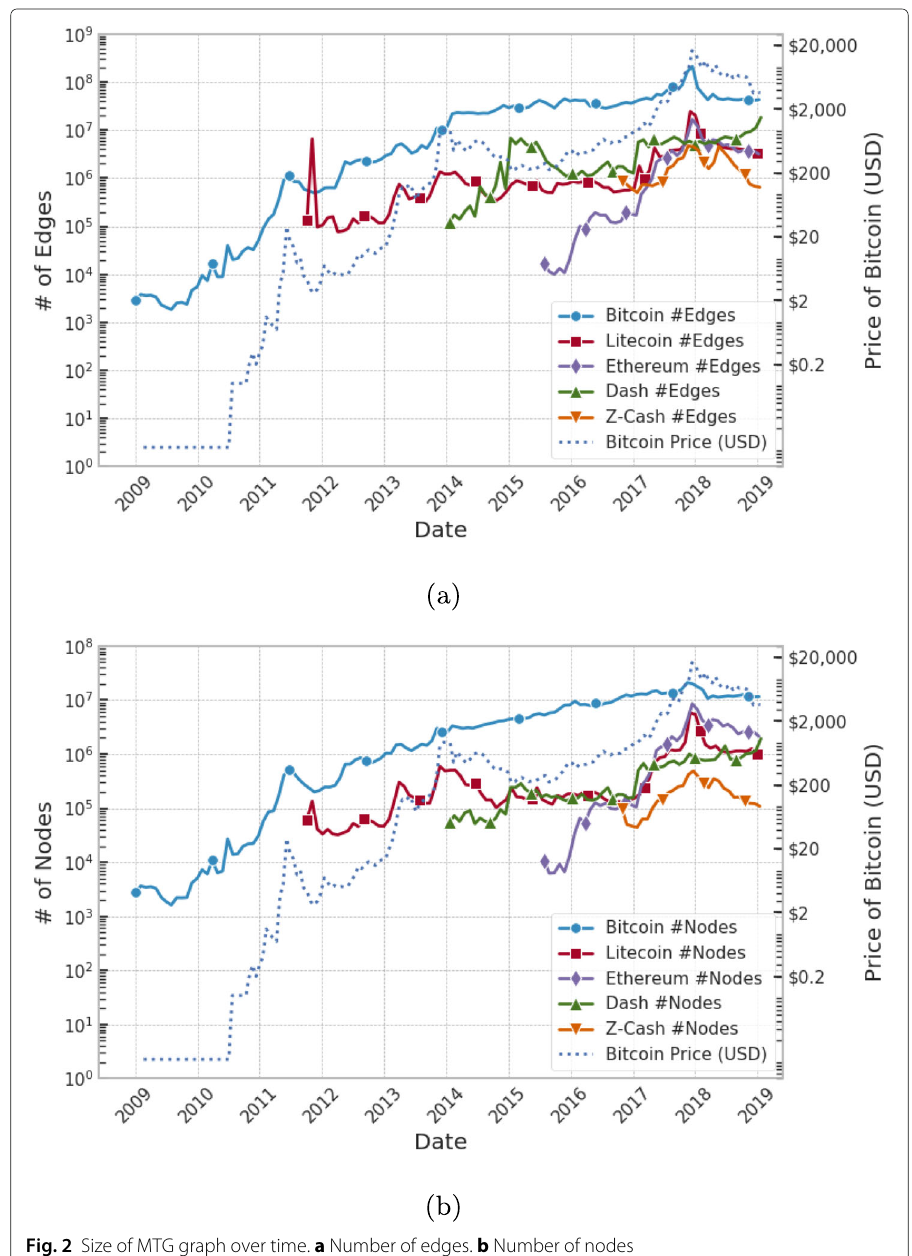
Fig. 2 Size of MTG graph over time. a Number of edges. b Number of nodes